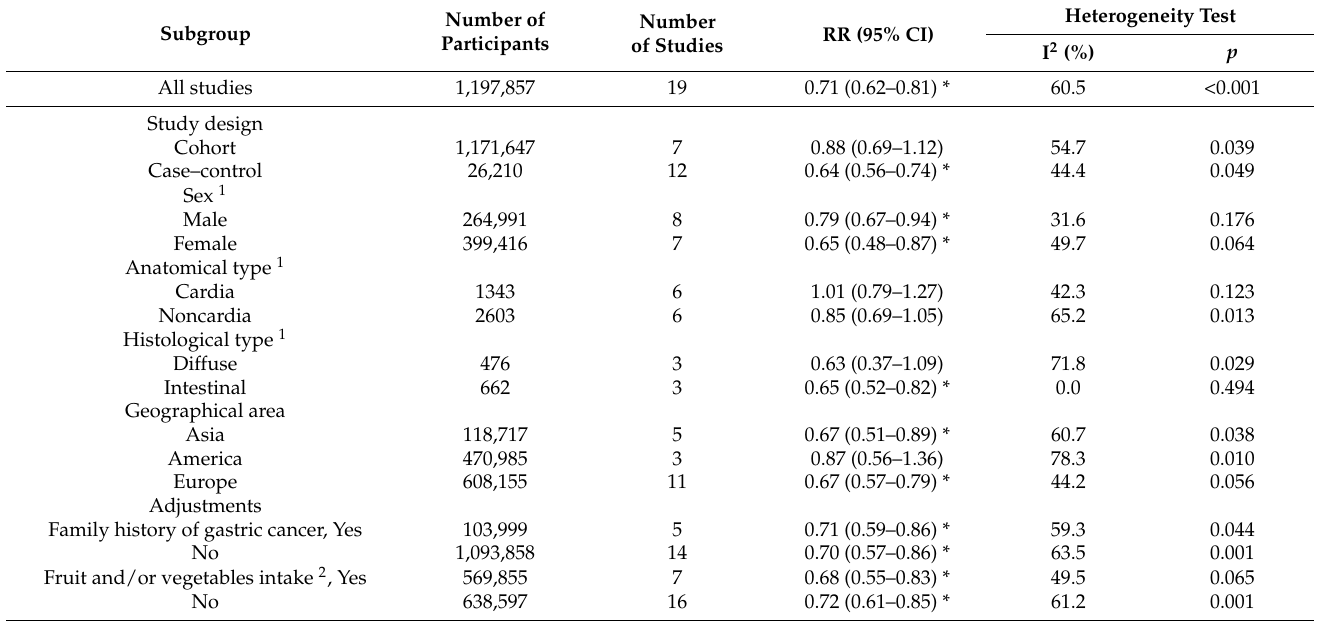
Table 2. Subgroup analyses of dietary polyphenol intake and gastric cancer risk.